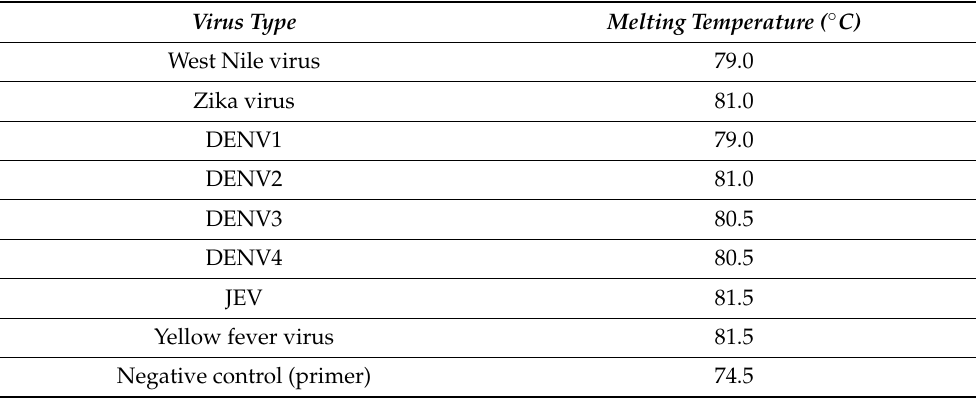
Table 3. Melting temperature of different flaviviruses generated during the development of the pan-flavivirus qPCR